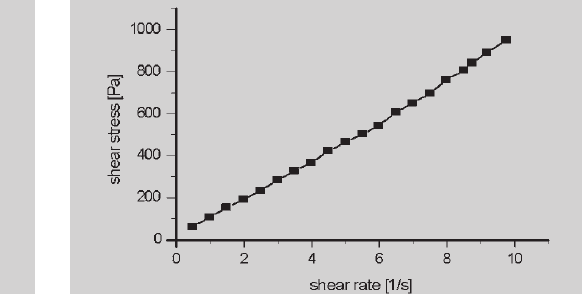
Figure 2 (left): Schematic presentation of velocity profiles as a function of the barrel radius (A and B) and the capillary radius (C and D) (all dimensions in mm, experimental curves ( Ç ), analytical curves (lines)). Figure 3 (right): The flow curve for epoxy resin (Newtonian